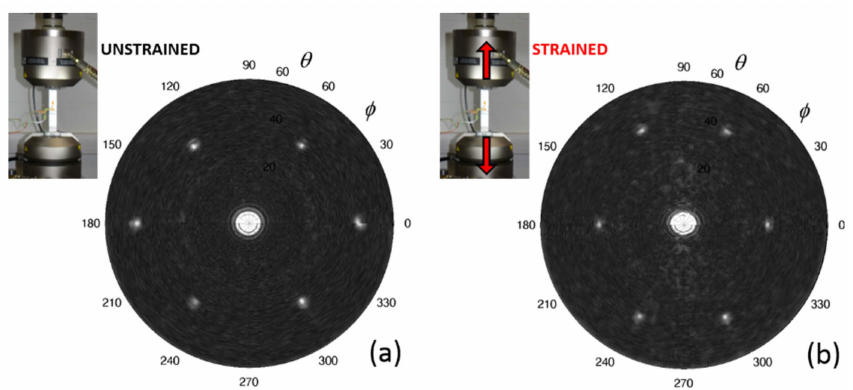
Figure 14. H-UBPS for DC06 steel coupon at f = 5 MHz: unstrained ( a ) and strained ( b )